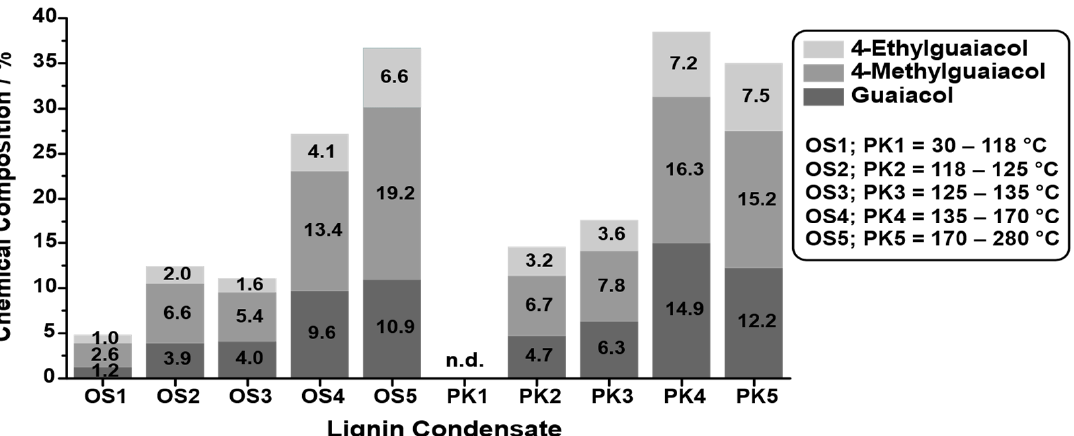
Figure 10. Mass percent of the main products guaiacol (dark grey), 4-methylguaiacol (grey), and 4-ethylguaiacol (light grey) in the condensates of the microwave-assisted pyrolysis of the SOSL (OS) and PKL (PK) at 30–118 °C (OS1/PK1), 118–125 °C (OS2/PK2), 125–135 °C (OS3/PK3), 135–170 °C (OS4/PK4), and 170–280 °C (OS5/PK5).